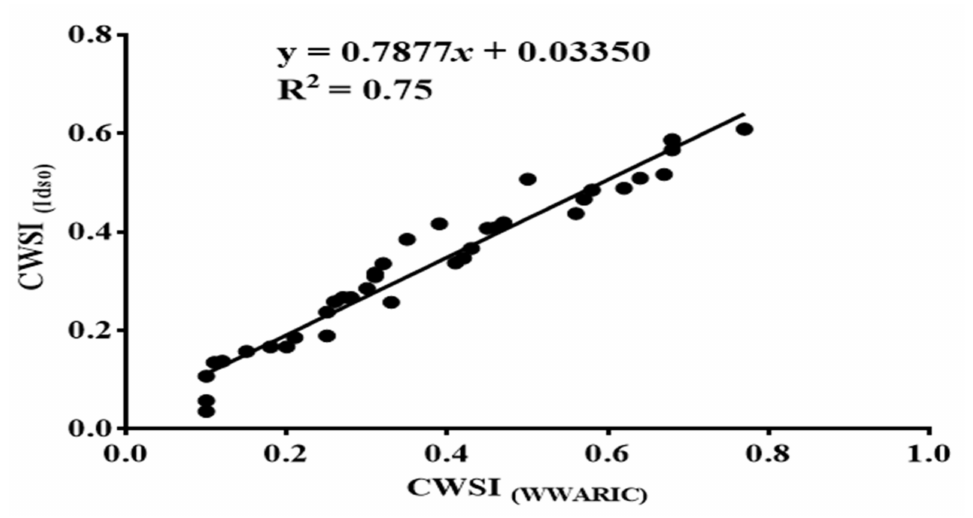
Figure 12. Correlation between CWSI calculated from Idso procedures and CWSI from WWARIC.